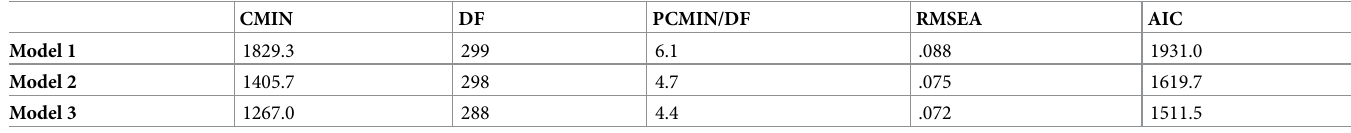
Table 2. Goodness of fit measures for structural equation